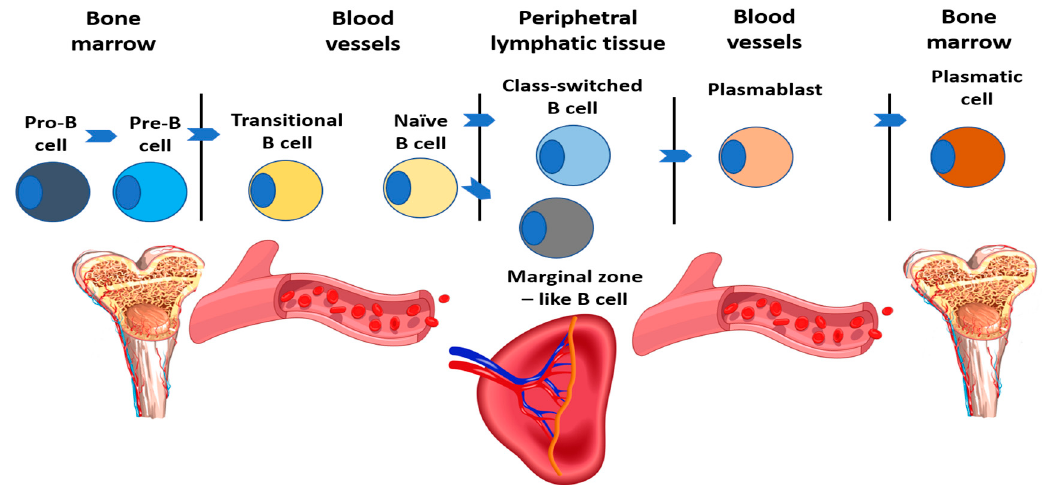
Figure 1. B cell development scheme, adapted from Warnatz et al. (2008) [50].